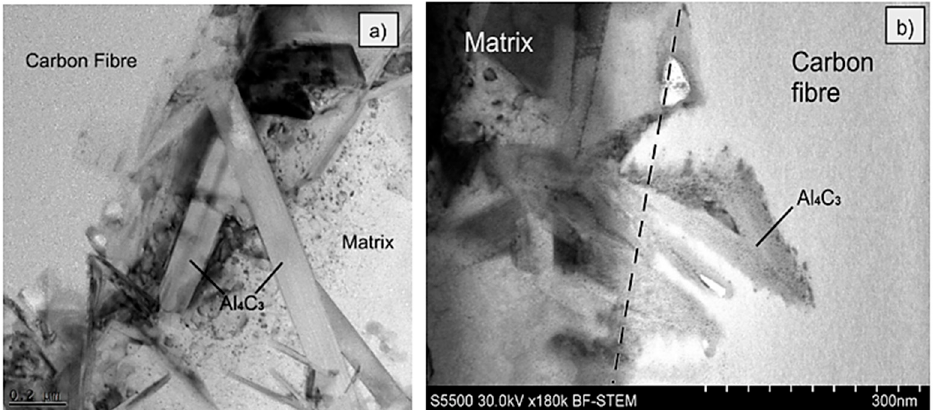
Figure 13 . EDS analysis of the interface between the fibre and the aluminium alloy matrix of MMC3 sample before push-out test.